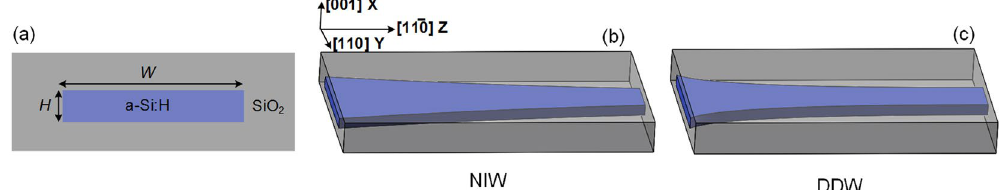
Figure 1. Schematics of the ( a ) cross-section, and the three-dimensional view of ( b ) nonlinearity increasing and ( c ) dispersion decreasing tapered